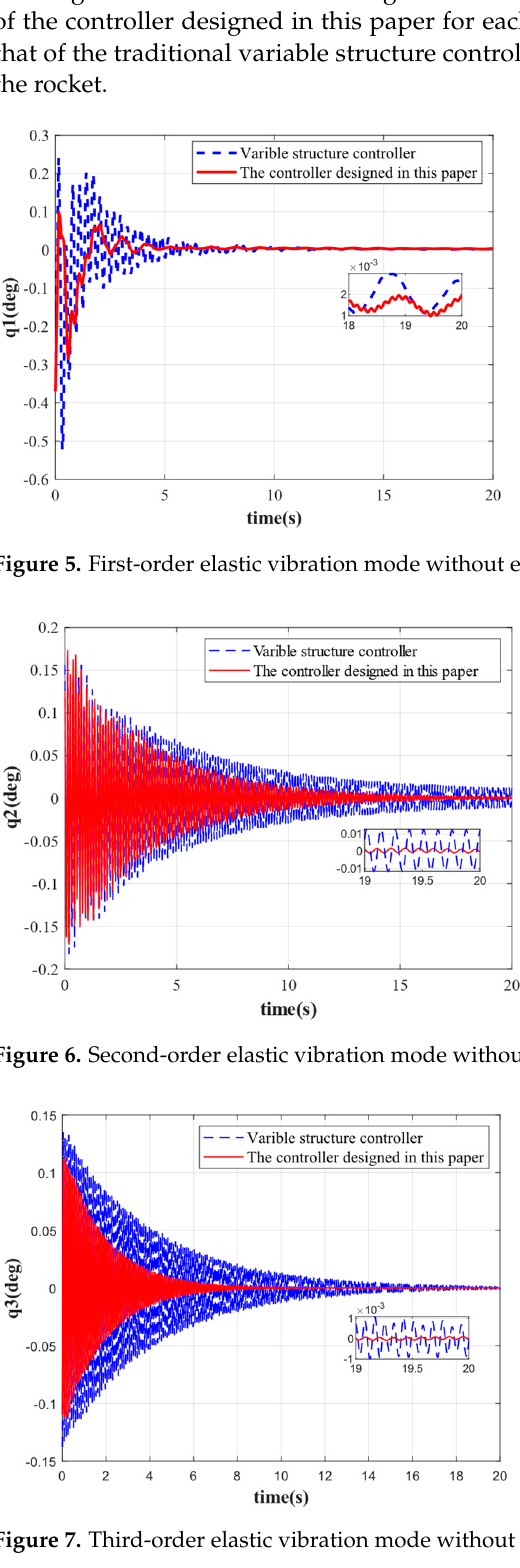
Figure 8. Fourth ‐ order elastic vibration mode without external interference.